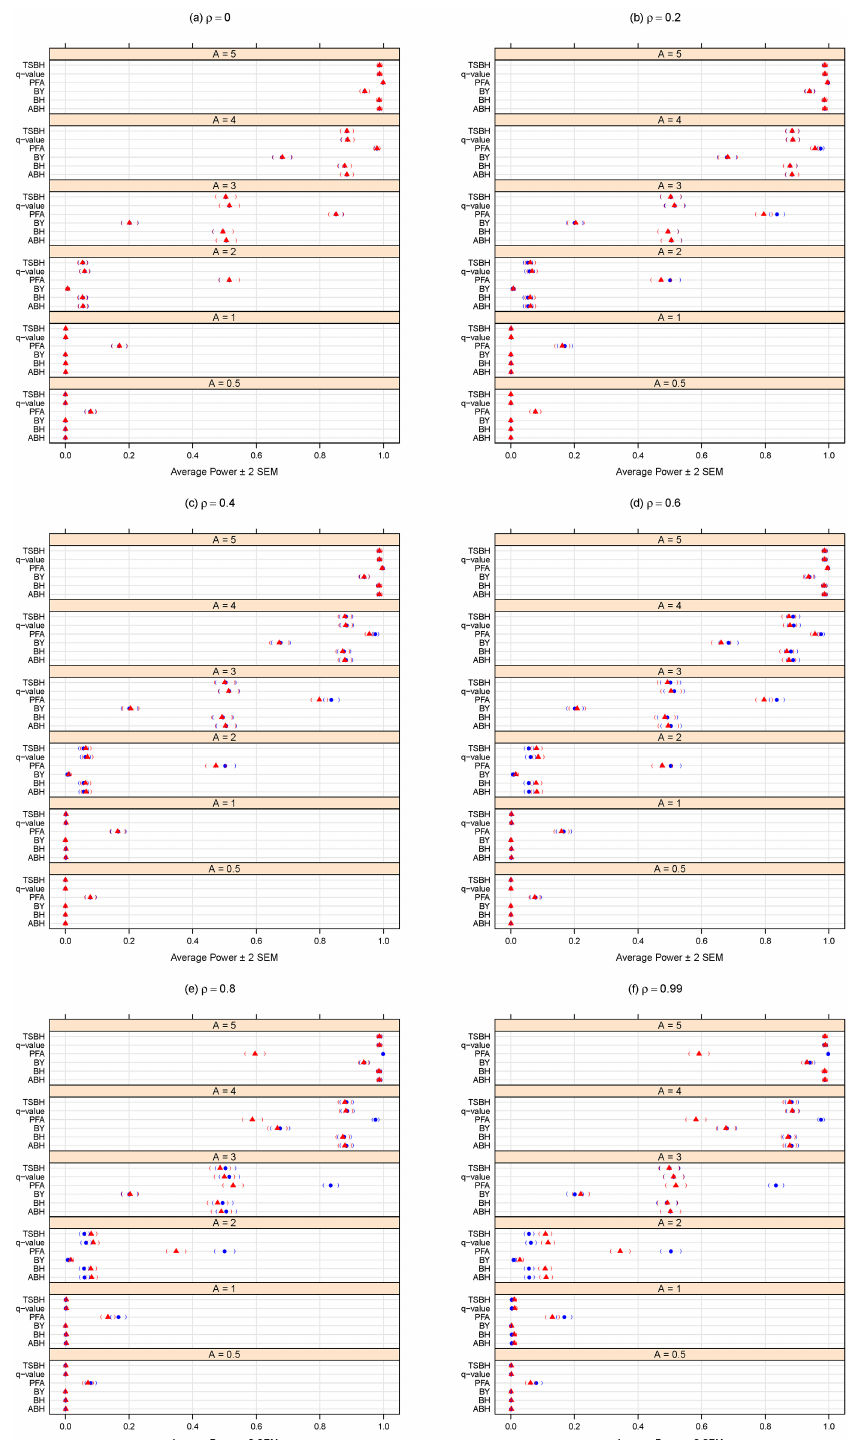
Fig 4. Average power for different methods purporting to control the FDR at α = 0.05. A can be thought of as the magnitude of differentialabundance for truly differentiallyabundantfeatures, and ρ is the true correlationwithin blocks of dependent tests. The blue solid circles represent the case of 120 dependenttests (out of 2000total), whereasthe red solid trianglesare for the case of 360 dependent tests. Parentheses indicate ± 2